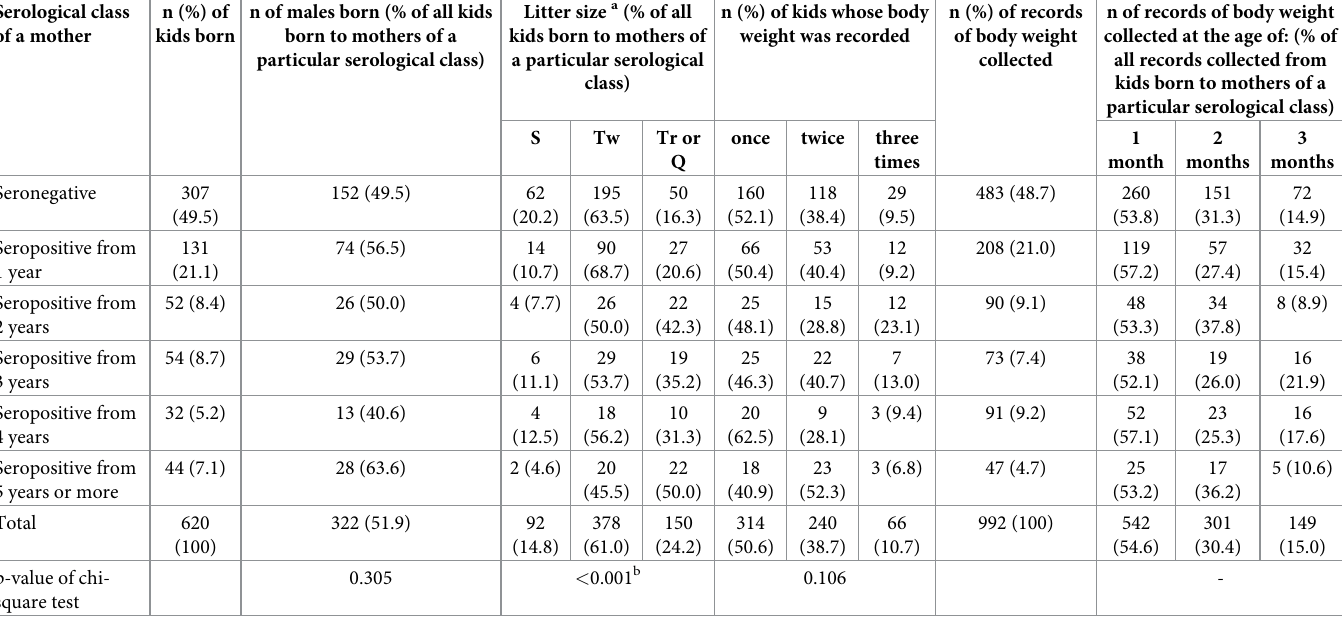
Table 1. General characteristics of the study population of goat kids. Serological class of a